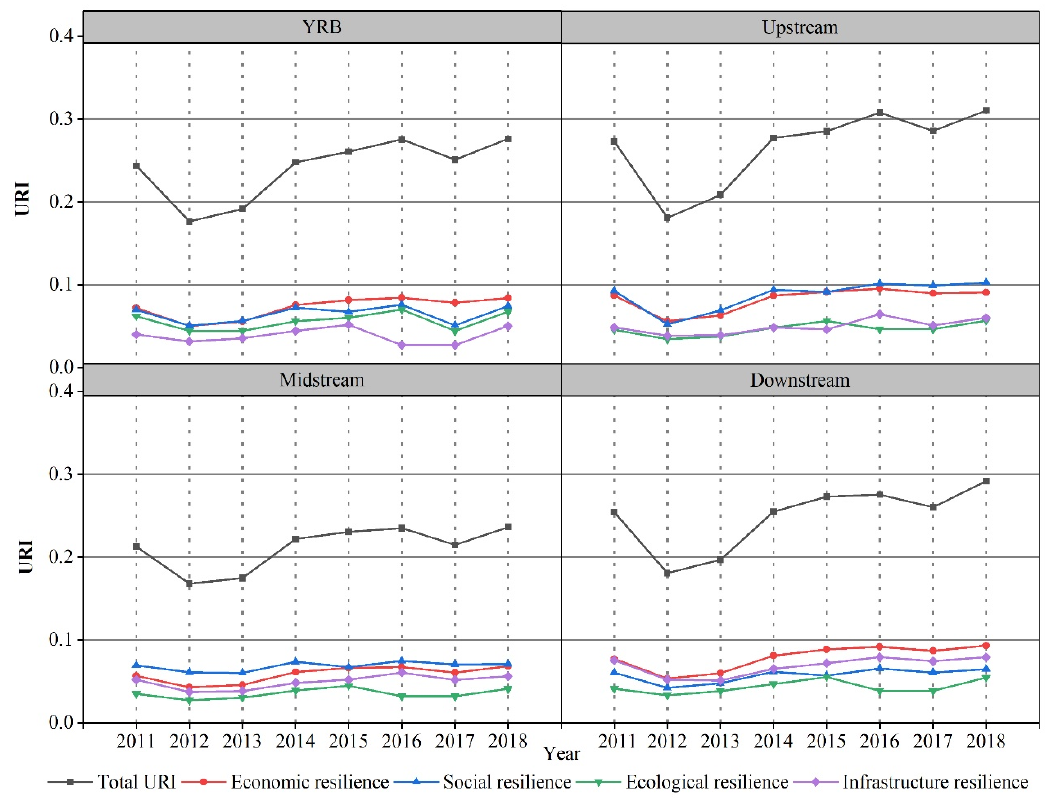
Figure 2. Temporal evaluation of the URI and subsystems in the YRB during 2011–2018.